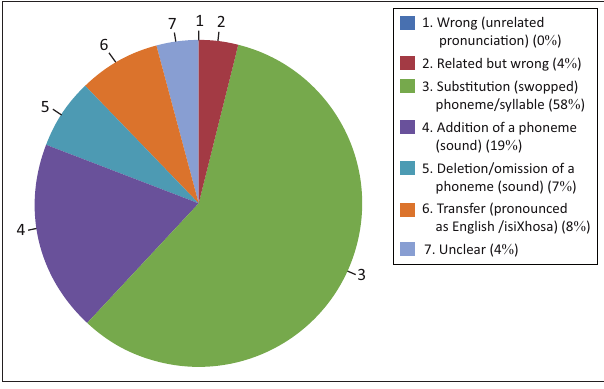
FIGURE 3: School X isiXhosa real-word reading ( n = 26). Sublexical decoding strategies.